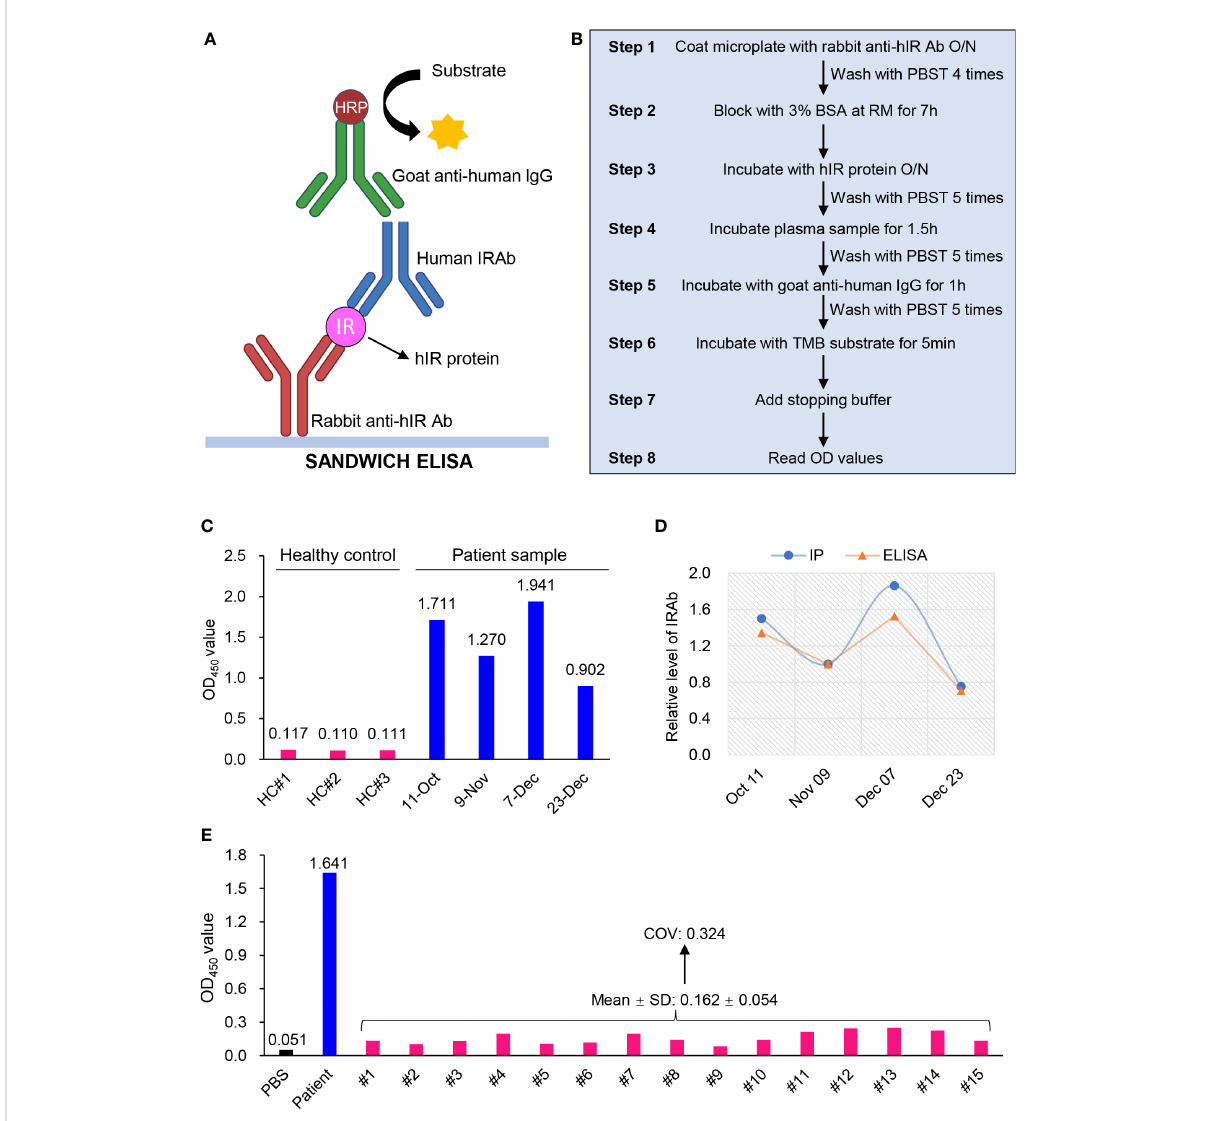
FIGURE 5 Development and validation of an ELISA kit for IRAb detection. (A) Diagram showing the sandwich ELISA principle for IRAb detection. (B) Summarized scheme for the preparation of IRAb ELISA kit and the measurement procedures. (C) The OD 450 values for IRAb detection by ELISA kit in three healthy controls and this patient. The patient plasma samples were collected from Oct 11 to Dec 23, 2020. (D) Quanti fi cation of relative IRAb titers by immunoprecipitation (IP) assay and ELISA in the same patient plasma samples collected from Oct 11 to Dec 23, 2020. (E) The OD 450 values for IRAb detection by ELISA kit in 15 healthy controls. PBS and patient sample as blank control and positive control. COV, cut-off value. SD, standard